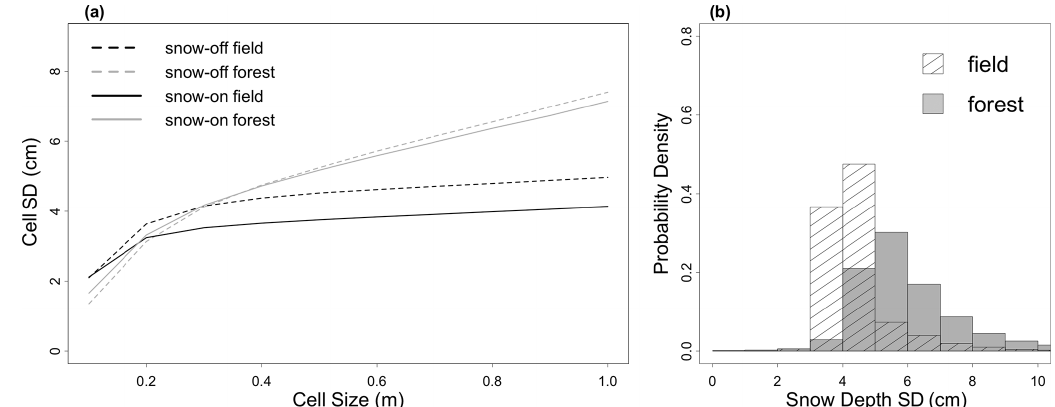
Figure 8. Lidar surface elevation standard deviations by (a) cell size and land cover. Cell standard deviations are the average of the individual cells’ standard deviation values calculated for cells with side dimensions ranging from 0.1 to 1.0m. (b) Probability density function of the snow depth’s pooled standard deviation for each 1m 2 cell in the forest (gray) and field